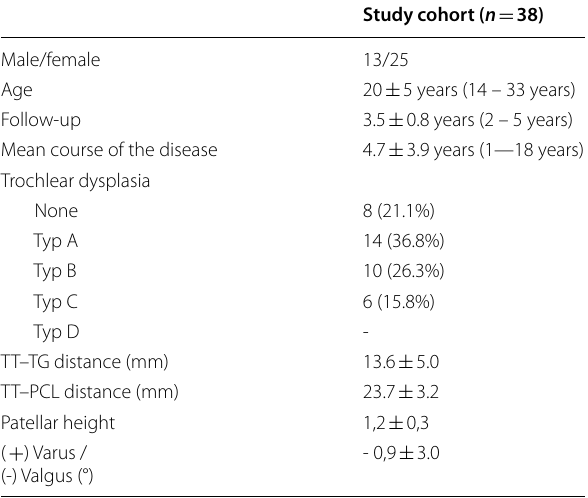
Table 1 Demographics and anatomical risk factors of patellar instability in the study